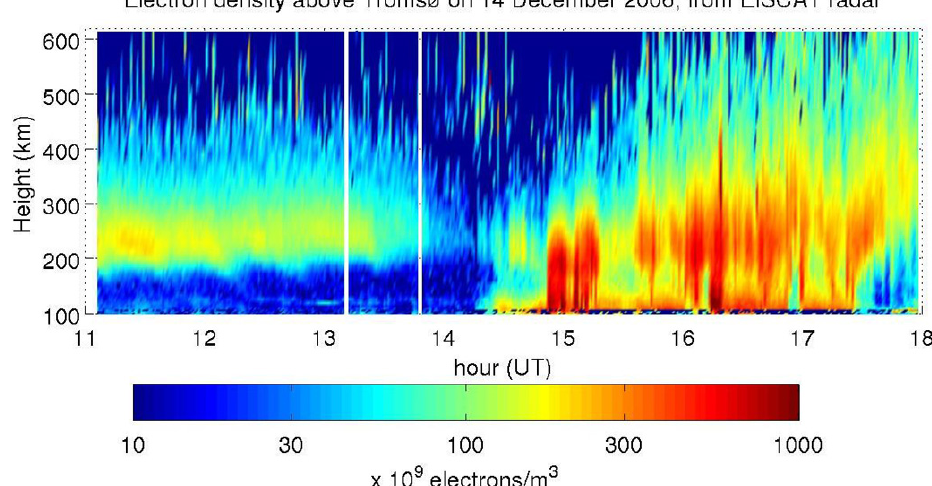
Fig. 8. Electron density measured by EISCAT at Tromsø on 14